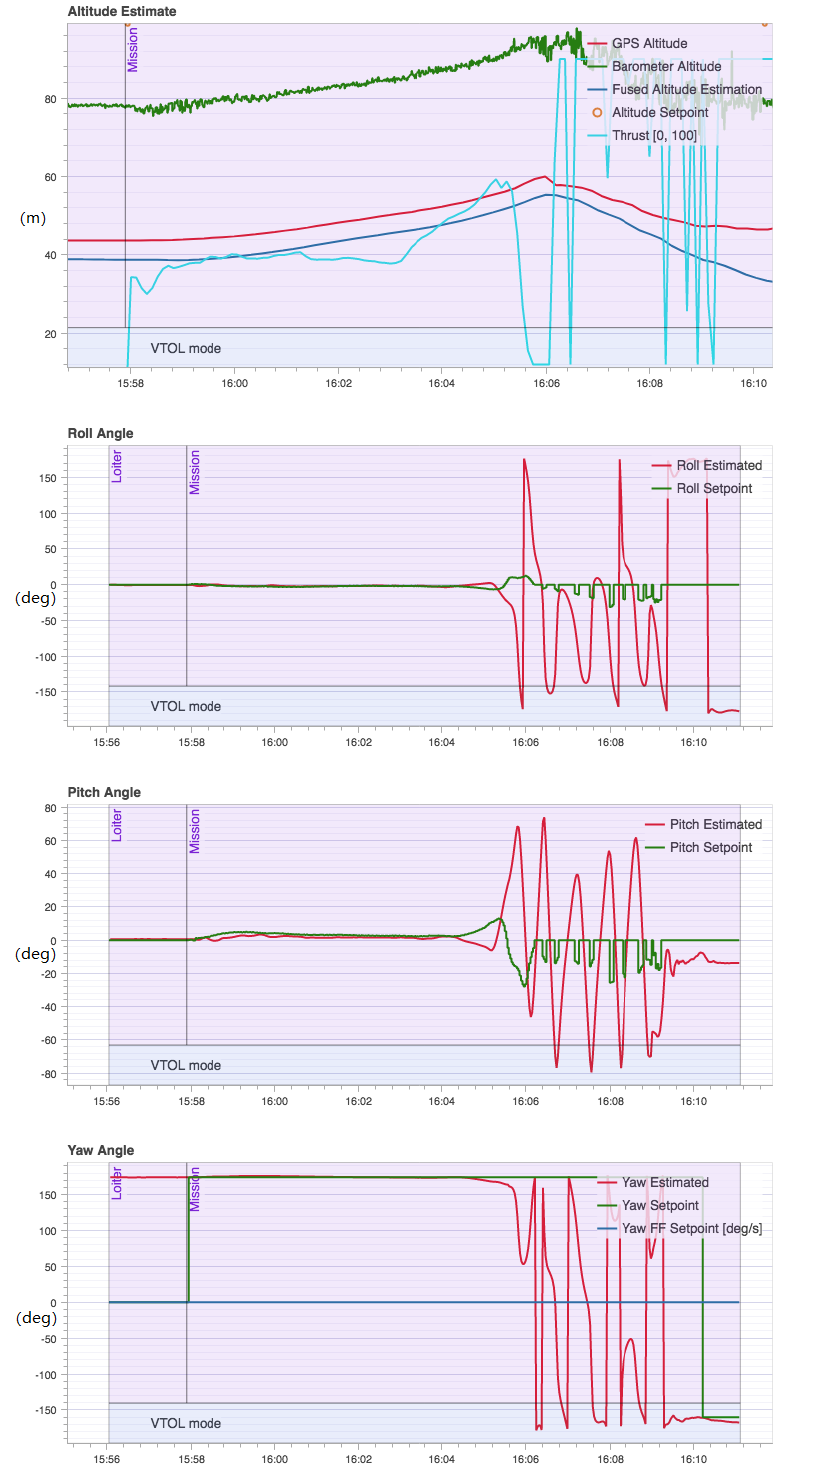
Figure 6. Altitude and attitude variation of the quadrotor during the hovering field